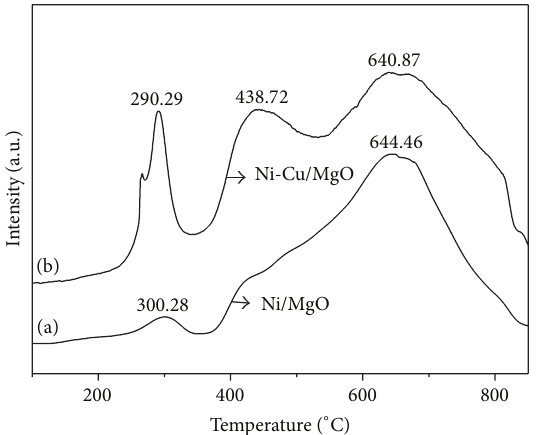
Figure 2: H 2 -TPR profiles of the catalysts (a) Ni/MgO and (b) Ni- Cu/MgO calcined at 500 ∘ C.